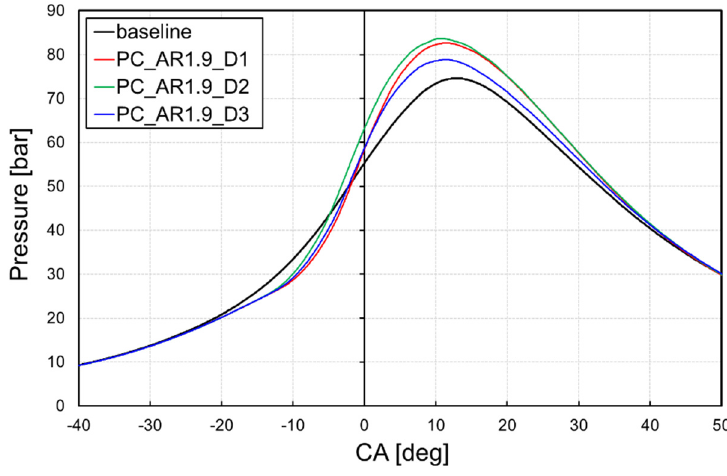
Figure 13. Influence of the orifice diameter on the in-cylinder pressure trend during combustion.